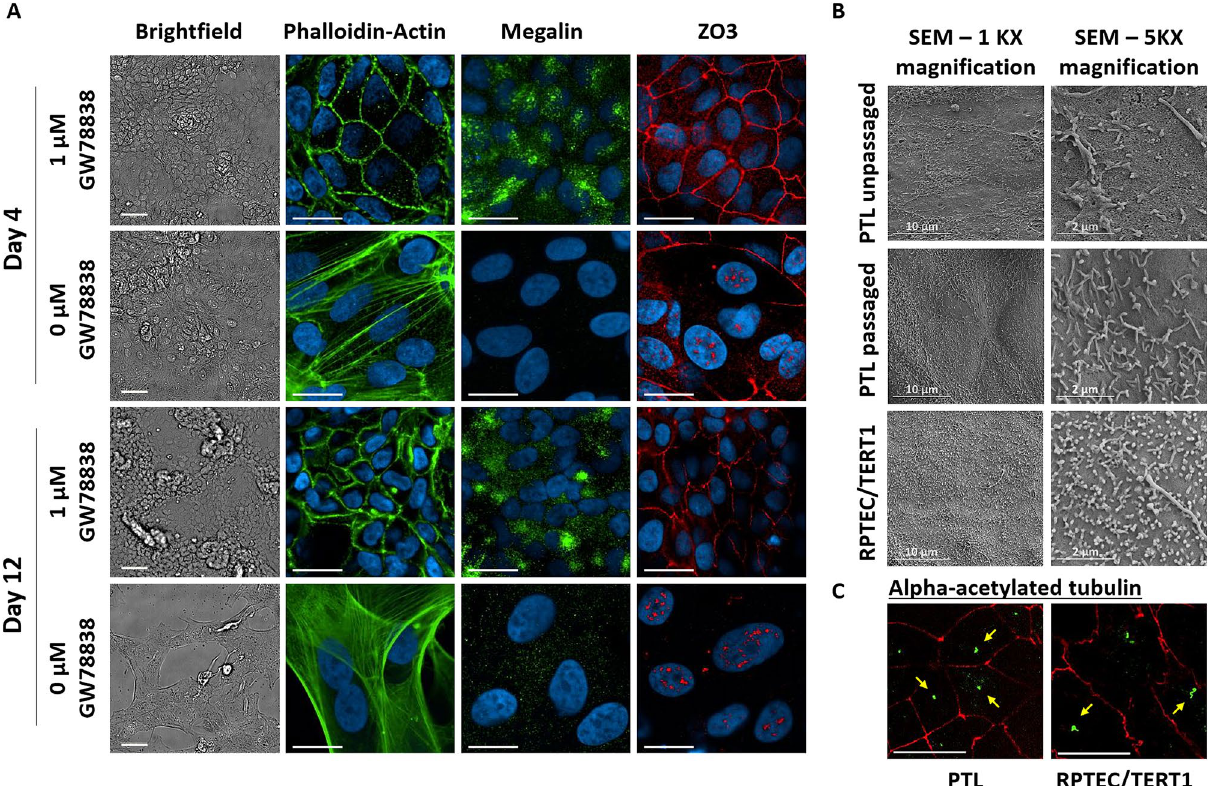
Figure 5. Light, electron and immunofluorescent microscopy images showing morphology of passaged and unpassed PTLs. ( A ) iPSC (SBAD2) were differentiated on Geltrex as indicated. On day 16 cells were passaged and plated on Geltrex in the presence or absence of 1 µM GW788388 hydrate. On day 4 and 12 cells were fixed in 4% PFA and stained with phalloidin, Hoechst and antibodies against megalin and ZO3. ( B ) For unpassaged cells, iPSC (SBAD3) were differentiated on 24 well transwell filters for 16 days. Passaged cells were differentiated on 6 well plastic dishes for 16 days and passaged onto transwell filters and cultured for 10 days. RPTEC/TERT1 were cultured on transwell filters for comparison. Samples were fixed with glutaraldehyde/PFA solution and processed for SEM images. ( C ) PTL and RPTEC/TERT1 cultured on 96 well plates were fixed and stained with alpha-acetylated tubulin (green: pointed out by yellow arrow) along with occludin (red). Images from different z-planes were combined. Scale bars are 20 µm unless stated